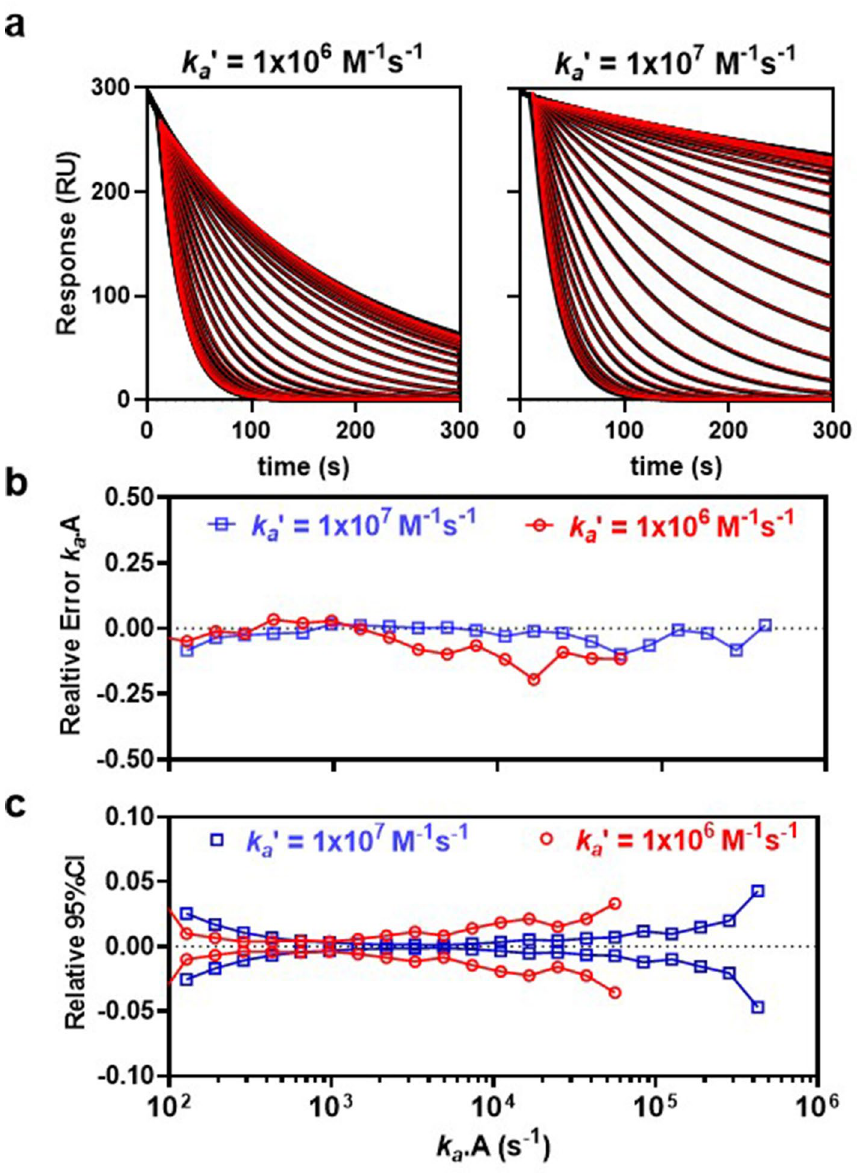
Figure 3. Estimation of k a from individual inhibition curves at two values of k a ′ . ( a ) Fitted inhibition curves for moderate- (left panel Da = 8.7) and high- (right panel, Da = 87) mass transport limitation. Inhibition curves (black) were fit (red) to Eq. (4), where k a was fit locally, giving independent estimates of k a for each curve, while all other parameters were held constant. ( b ) Relative error in k a .A as a function of true k a .A . All values where the absolute relative error was < 0.2 are shown. Relative error = 1-(true_ k a . A / k a . A ). ( c ) 95% confidence intervals expressed as a fraction of estimated k a .A and plotted versus true k a .A and were < 0.05. Details of the numerical simulations in ( a ) are as follows. At t = 0 s, B is pre-bound to the hydrogel to a concentration equivalent to R 0 = 300 RU = 0.1R max . At t = 10 s, 0.5 mM A is injected inhibiting rebinding of B thereby accelerating escape of B . The inhibition curves were simulated over serial 1.5-fold increasing k a and included a blank inhibition curve, where A = 0. Other simulation parameters were as follows, k d = 0.001 s −1 , k d ′ = 0.05 s −1 , h = 10 μm and ν c = 0.15 m/s. Inhibition curves were simulated using the virtual instrument and finite element analysis engine described in the Method